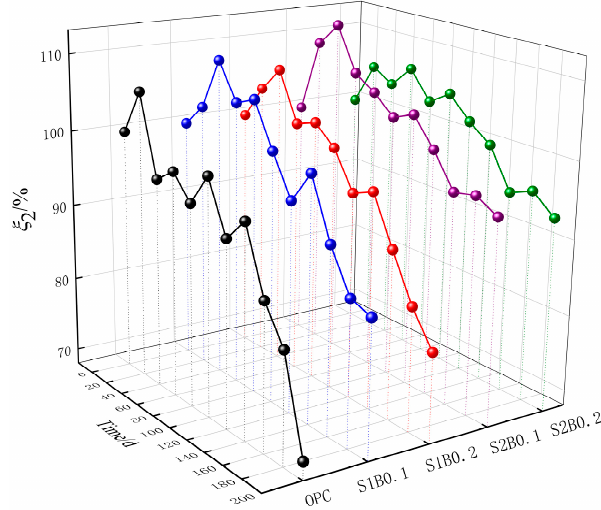
Figure 4. Time variation curve of relative mass evaluation parameters.